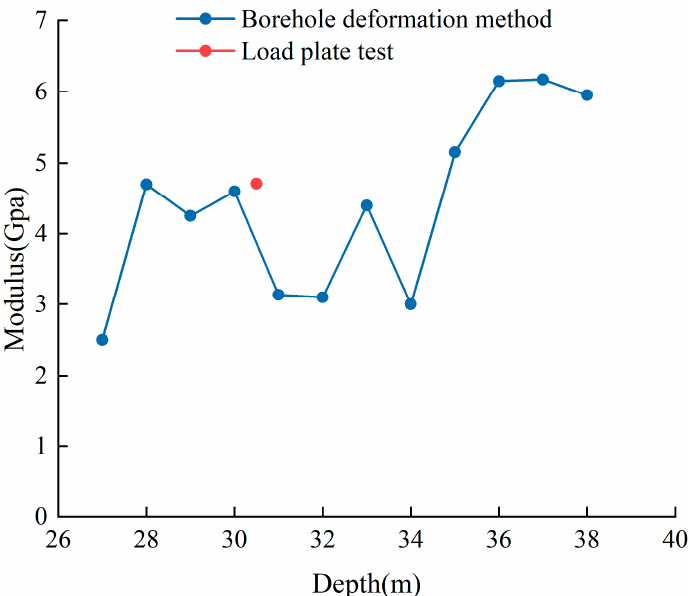
Figure 8. Comparison between borehole deformation method and pressure plate test.